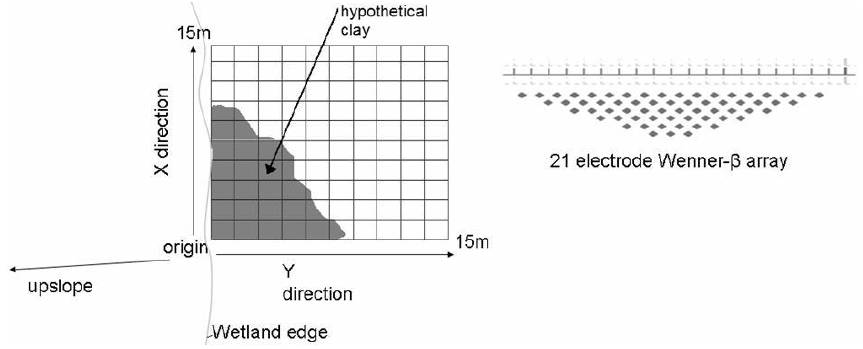
Fig. 2. Grid design and placement of the Wenner- β × 21 transects at the wetland-footslope interface and the data point distribution of the